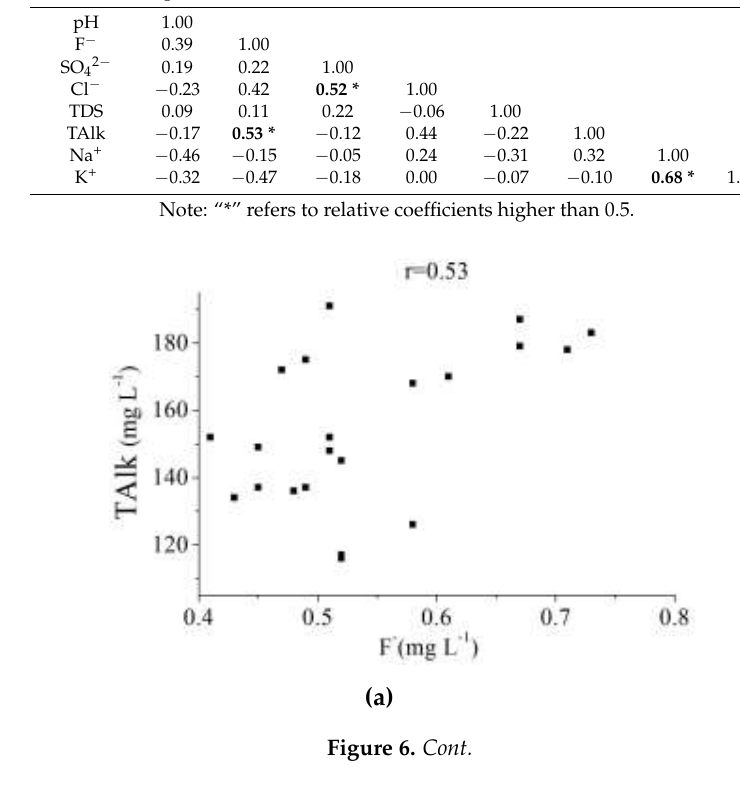
Table 3. Correlation matrix of parameters in the studied area. Parameters